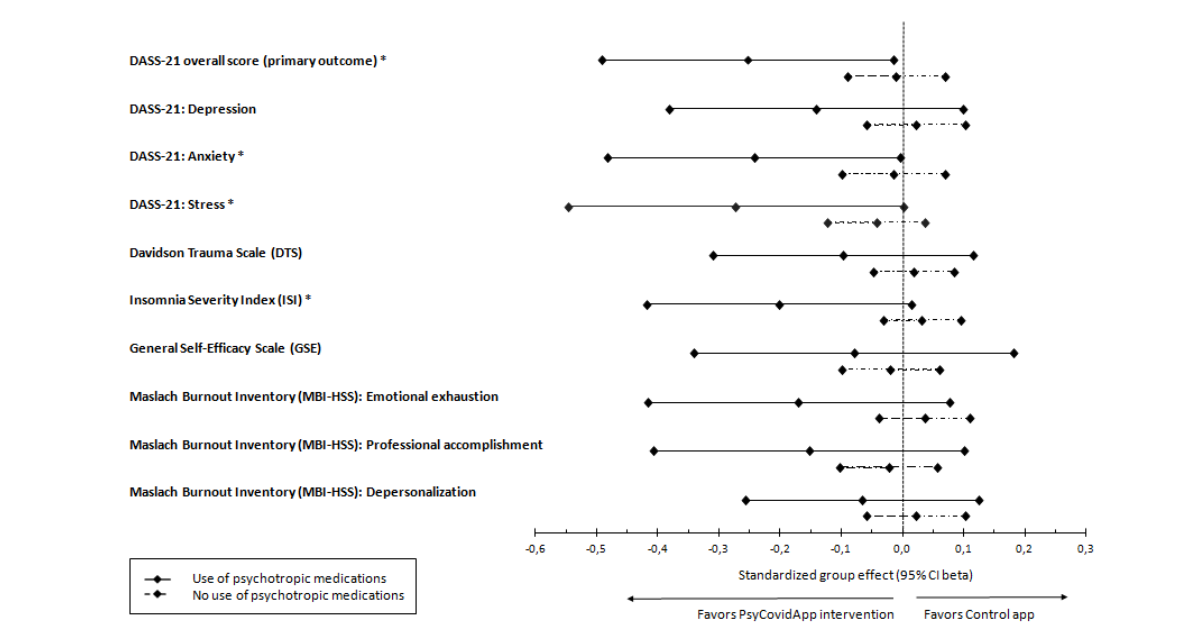
Figure 3. Standardized mean differences for primary and secondary outcomes in healthcare workers reporting the use of psychotropic medications at baseline. Forest plot of standardized group differences between PsyCovidApp and Control App groups for all outcomes, whereby an effect lower than 0 favored the PsyCovidApp group. Error bars show 95% Confidence Intervals (CIs). DASS-21, Depression, Anxiety, and Stress Scale. * P <.05.